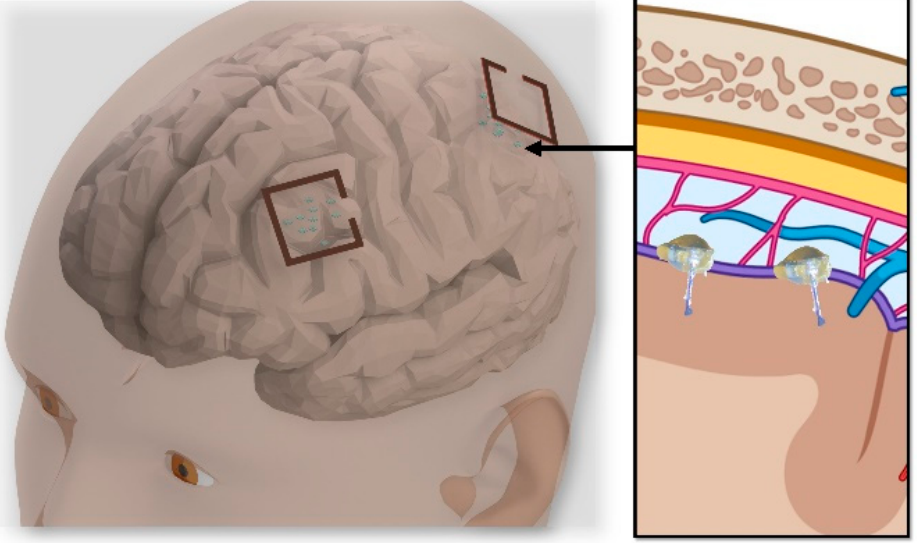
Figure 1. A conceptual diagram of the distributed interface using epicortical, single-channel, wireless implants.